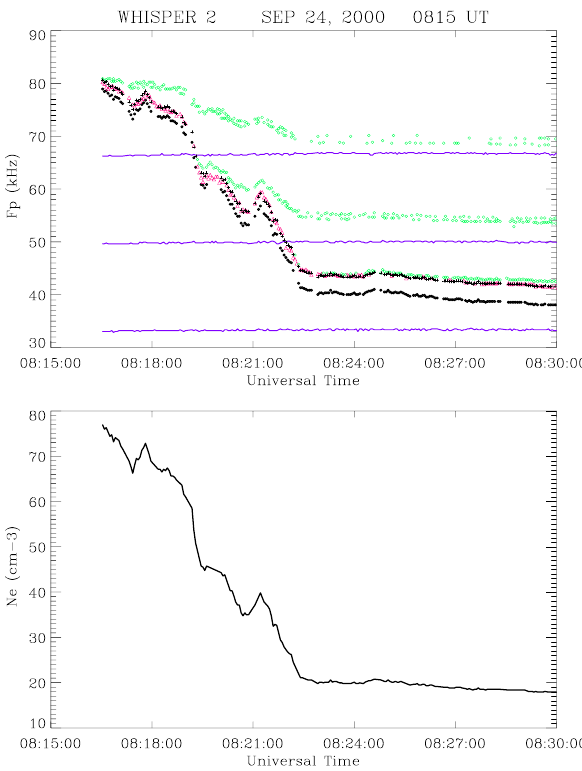
Fig. 9. Frequency of the recognized/calculated resonances (top) and inferred electron plasma densities (bottom) versus time. For com- parison, the observed resonances are shown in Fig. 8. The red stars in the bottom panel represent the observed total plasma density. For further details, see the